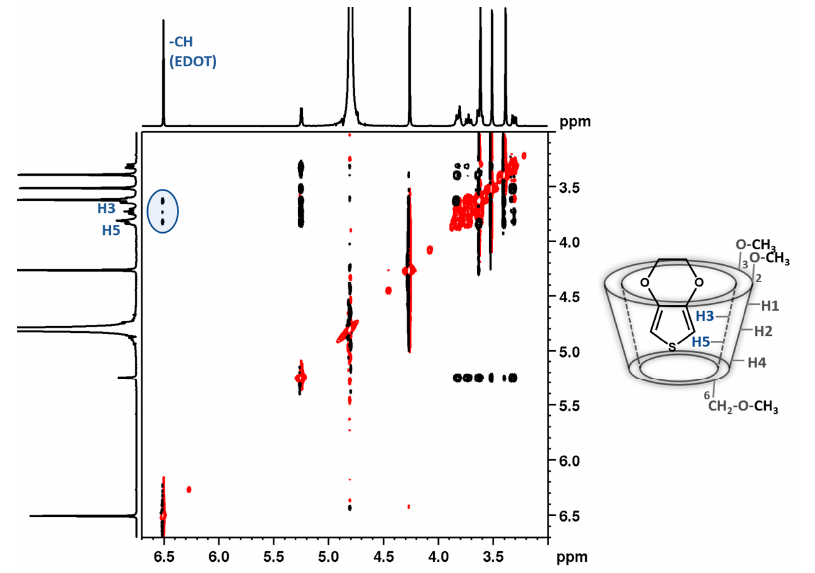
Figure 4. H-H ROESY (400 MHz, D 2 O) spectrum for EDOT ∙ TMe- β CD and possible inclusion geometry of EDOT inside the TMe- β CD cavity, in aqueous solution.